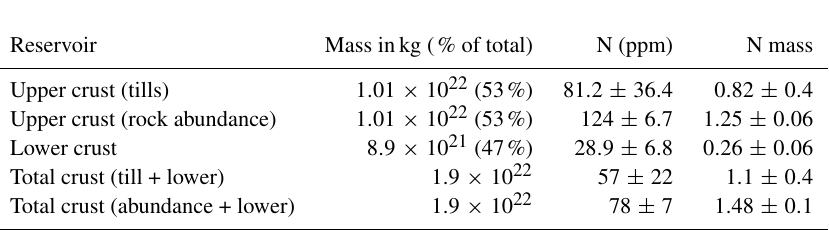
Table 7. Total continental crust N based on tills, rock proportions, and xenolith concentrations. Our results are consistent with previous work that suggests there is about 2 × 10 18 kgN in the continental crust. All N masses are 10 18